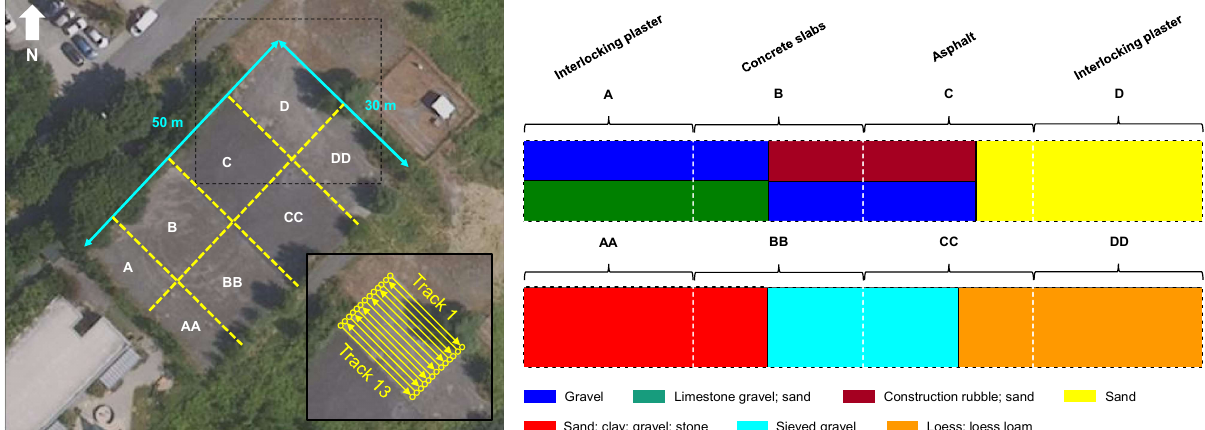
Figure 1 . Test site with sections A to D and AA to DD, and zoom on investigated part of the test site (D), respe ctively (left). Surface and subsurface materials of the sections (right).